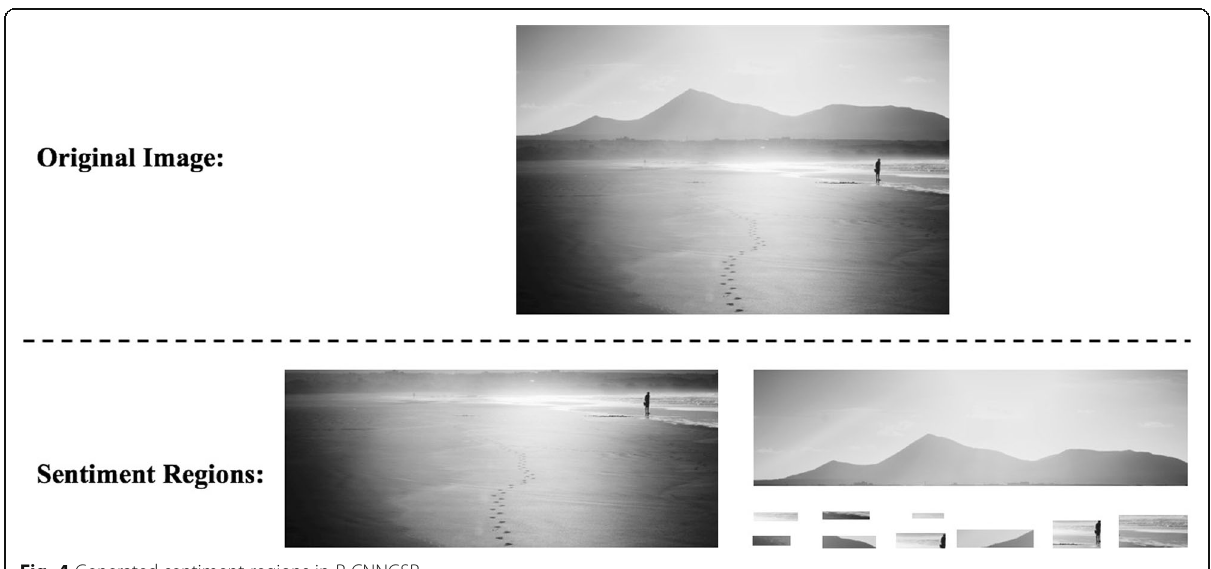
Fig. 4 Generated sentiment regions in R-CNNGSR